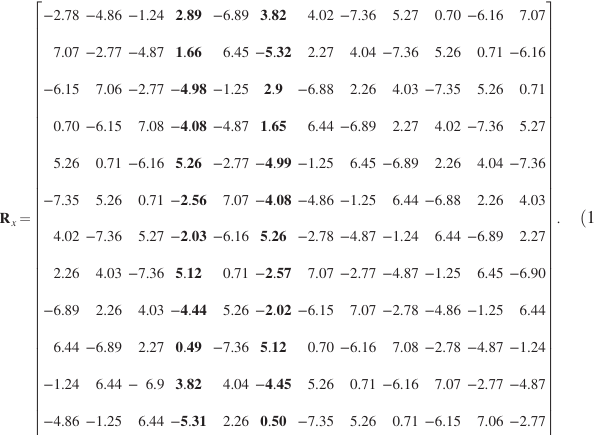
FIG. 2. Comparison of singular values of the SIS18 ORM with its nearest-circulant approximation and its pure-circulant approxi- mation in the x plane. The abscissa is the index of singular values of the matrix S , while the ordinate is the magnitude of the singular